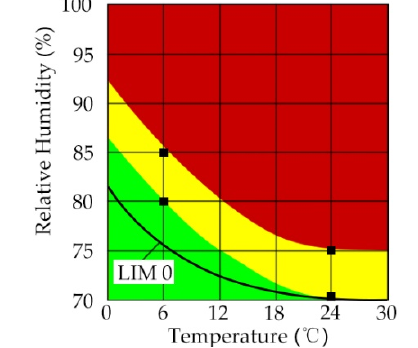
Figure 2. Isopleth system of wheat straw [22].